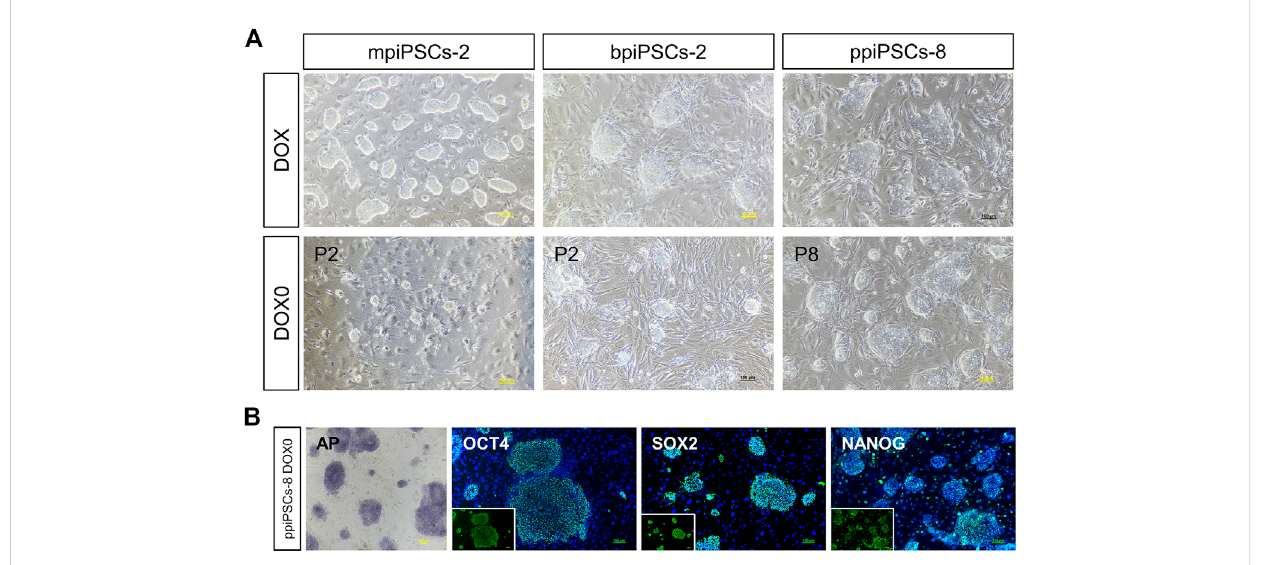
FIGURE 4 The morphology and pluripotency analysis of piPSCs after DOX withdrawal. (A) The morphology of piPSCs lines with or without DOX. Scale bar, 100 µm. (B) APstainingandimmuno fl uorescence analysis ofpluripotency markersOCT4, SOX2 andNANOG inppiPSCs atpassage5withoutDOX.Scale bar, 100